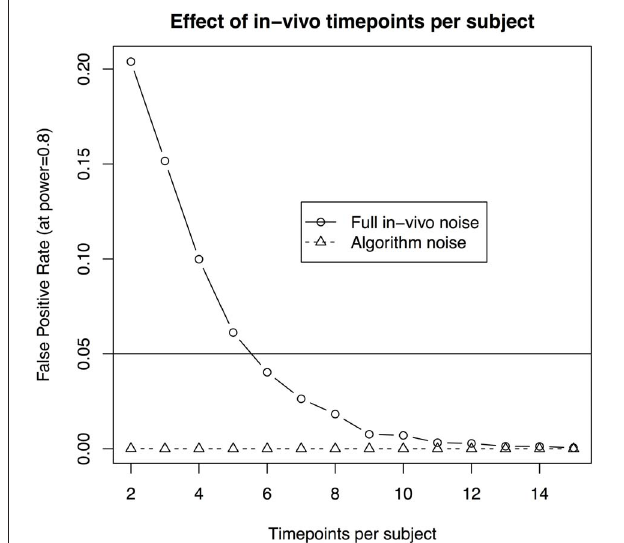
FIGURE 4 | The effect of scans per subject when assuming 10 subjects per group and aiming to recapture a 3% change in volume in a longitudinal in-vivo study. The solid line illustrates the statistical power using a standard deviation of 3.1%, as estimated from the in-vivo data. The dotted line shows the estimate based on a reduced standard deviation of 1.1%, the best estimate obtained by repeated scans of ex-vivo samples. The latter gives an approximation of imaging and algorithm